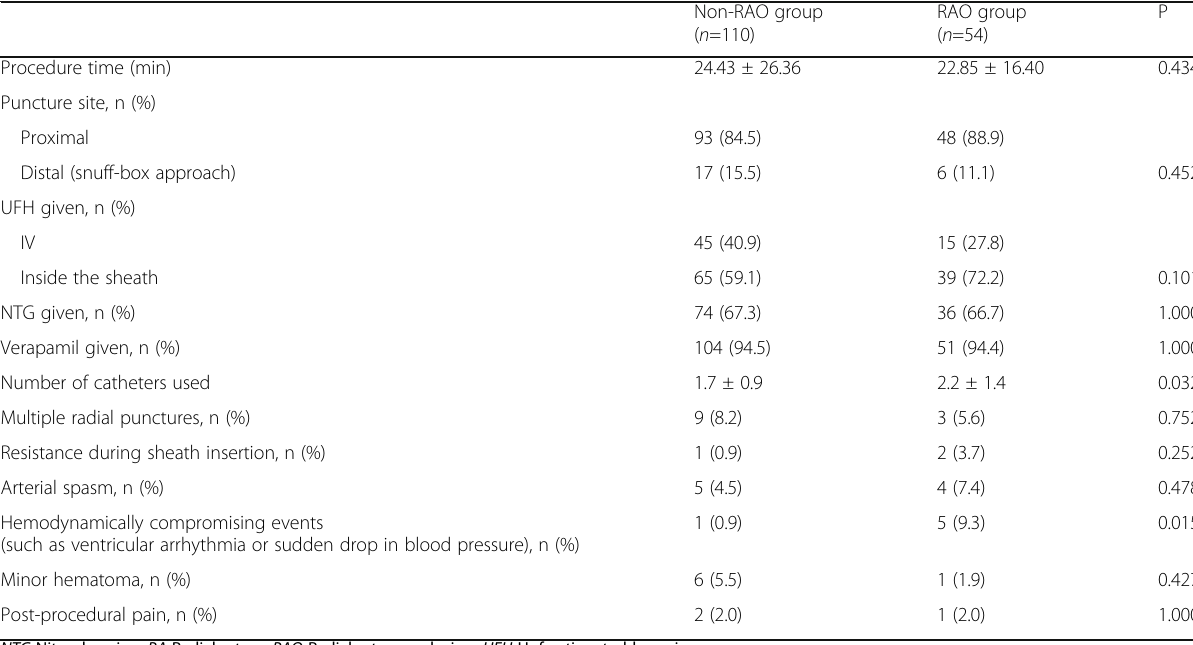
Table 3 Procedural data of the study groups